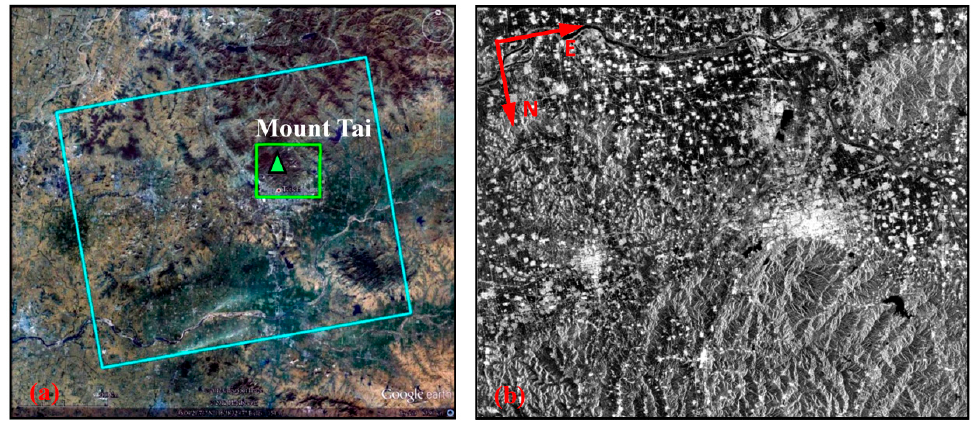
Figure 6. ( a ) The coverage of ALOS/PALSAR images marked by the blue rectangle and 1:25,000 DEM marked by the green rectangle shown in Google Earth; ( b ) the amplitude image of ALOS/PALSAR data (acquisition time: 6 February 2008).